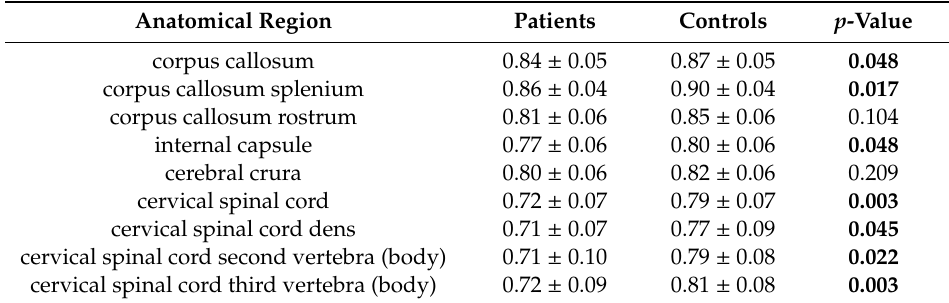
Table 2. Fractional anisotropy (FA) in HSP patients and